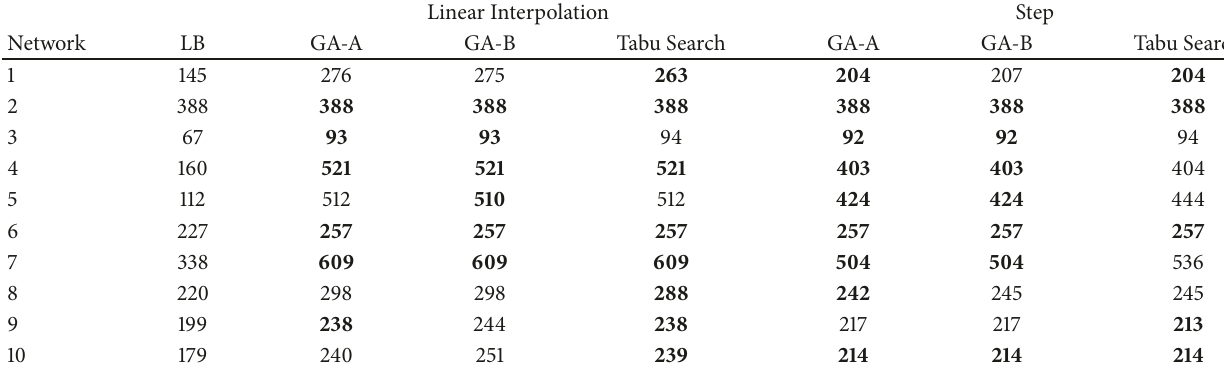
Table 3: Results for size 30